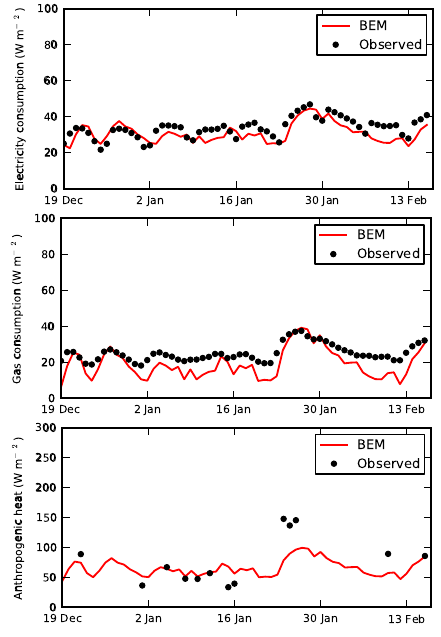
Fig. 9. Daily-average electricity consumption (top), natural gas consumption (middle) and anthropogenic heat (bottom) per unit of urban area from observations and calculated by BEM-TEB in win- ter for the dense urban centre of